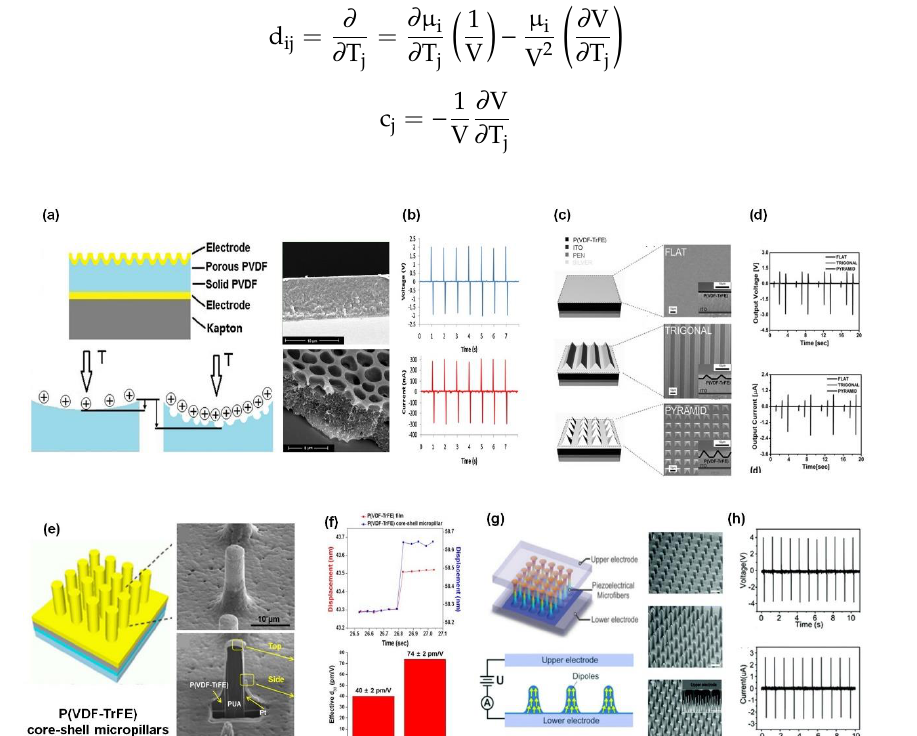
Figure 3. ( a ) Schematic illustration and SEM images of the mesoporous surface PVDF-based